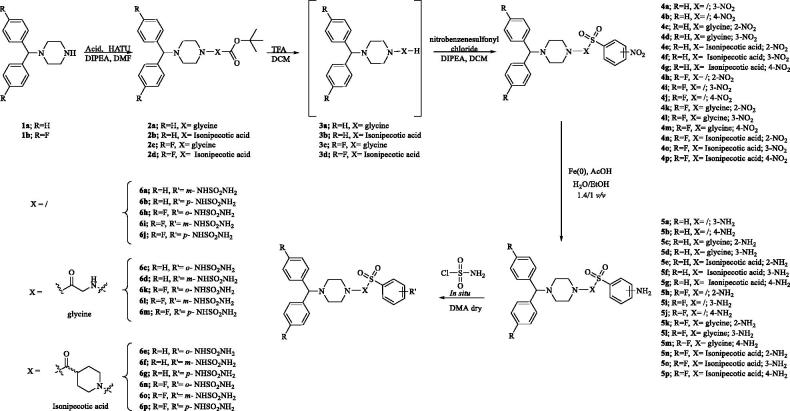
General synthetic scheme of compounds 6a–p.